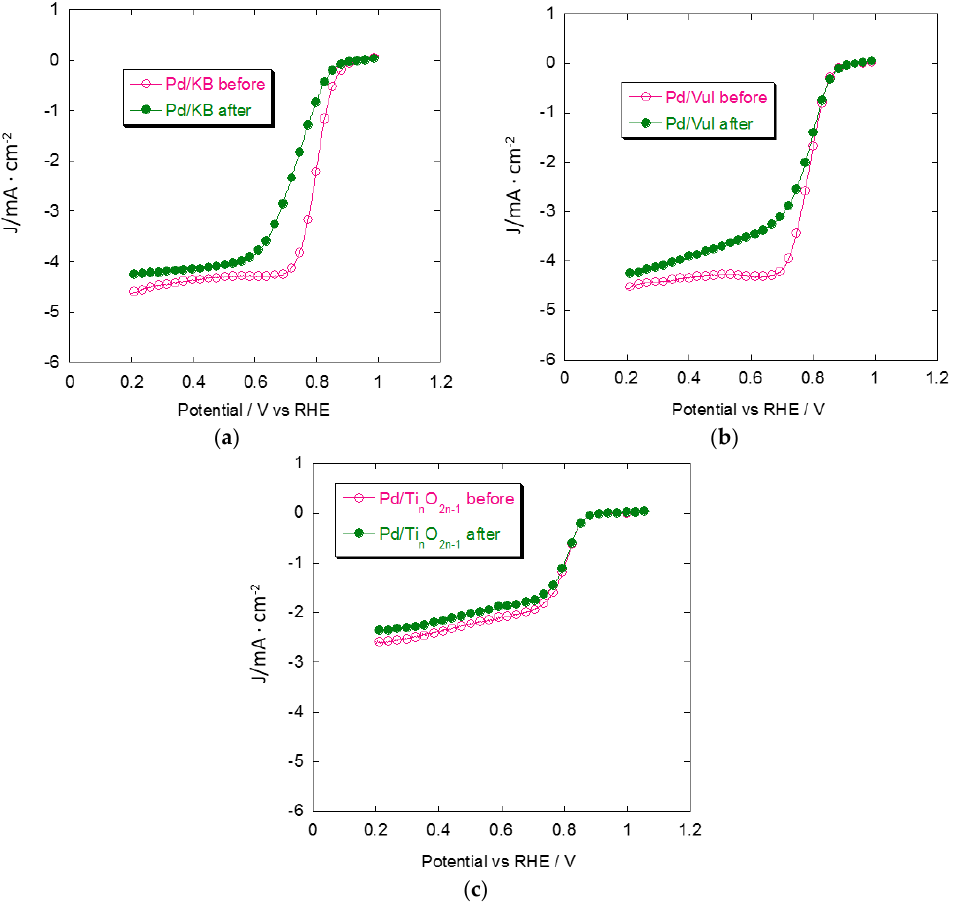
Figure 9. Oxygen reduction curves for the different Pd/support catalysts before and after degradation cycles. ( a ) Pd/KB; ( b ) Pd/Vul; ( c ) Pd/Ti n O 2 n –1 . Scan rate 5 mV·s − 1 ; 1000 rpm; room temperature and cycles. ( a ) Pd/KB; ( b ) Pd/Vul; ( c ) Pd/Ti n O 2 n ´ 1 . Scan rate 5 mV ¨ s ´ 1 ; 1000 rpm; room temperature 50 μ g·cm − 2 of Pd loading. and 50 µ g ¨ cm ´ 2 of Pd